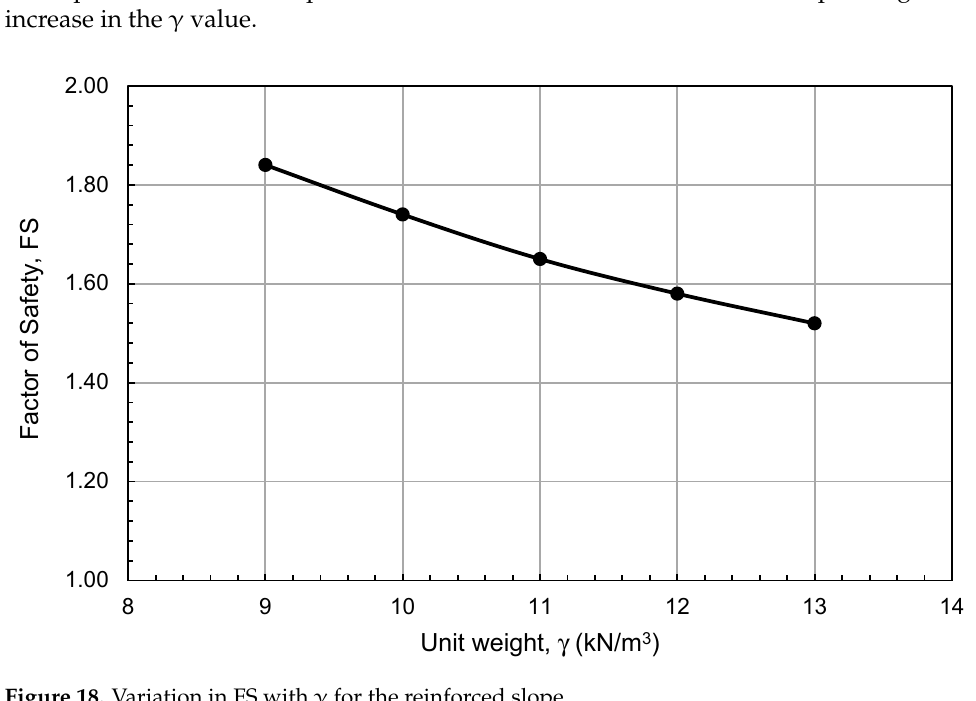
Figure 18. Variation in FS with γ for the reinforced slope.